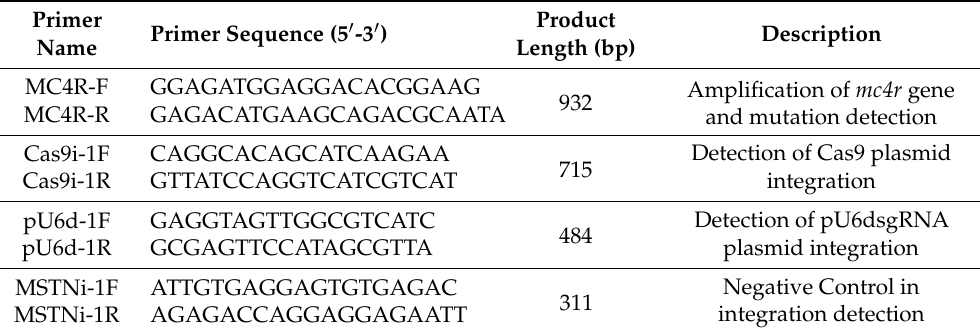
Table 2. Primers used in the polymerase chain reaction (PCR) for molecular cloning of the channel catfish, Ictalurus punctatus , melanocortin-4 receptor ( mc4r ) gene and detection of pU6dsgRNA and Cas9 plasmids’ integration in gene-edited channel